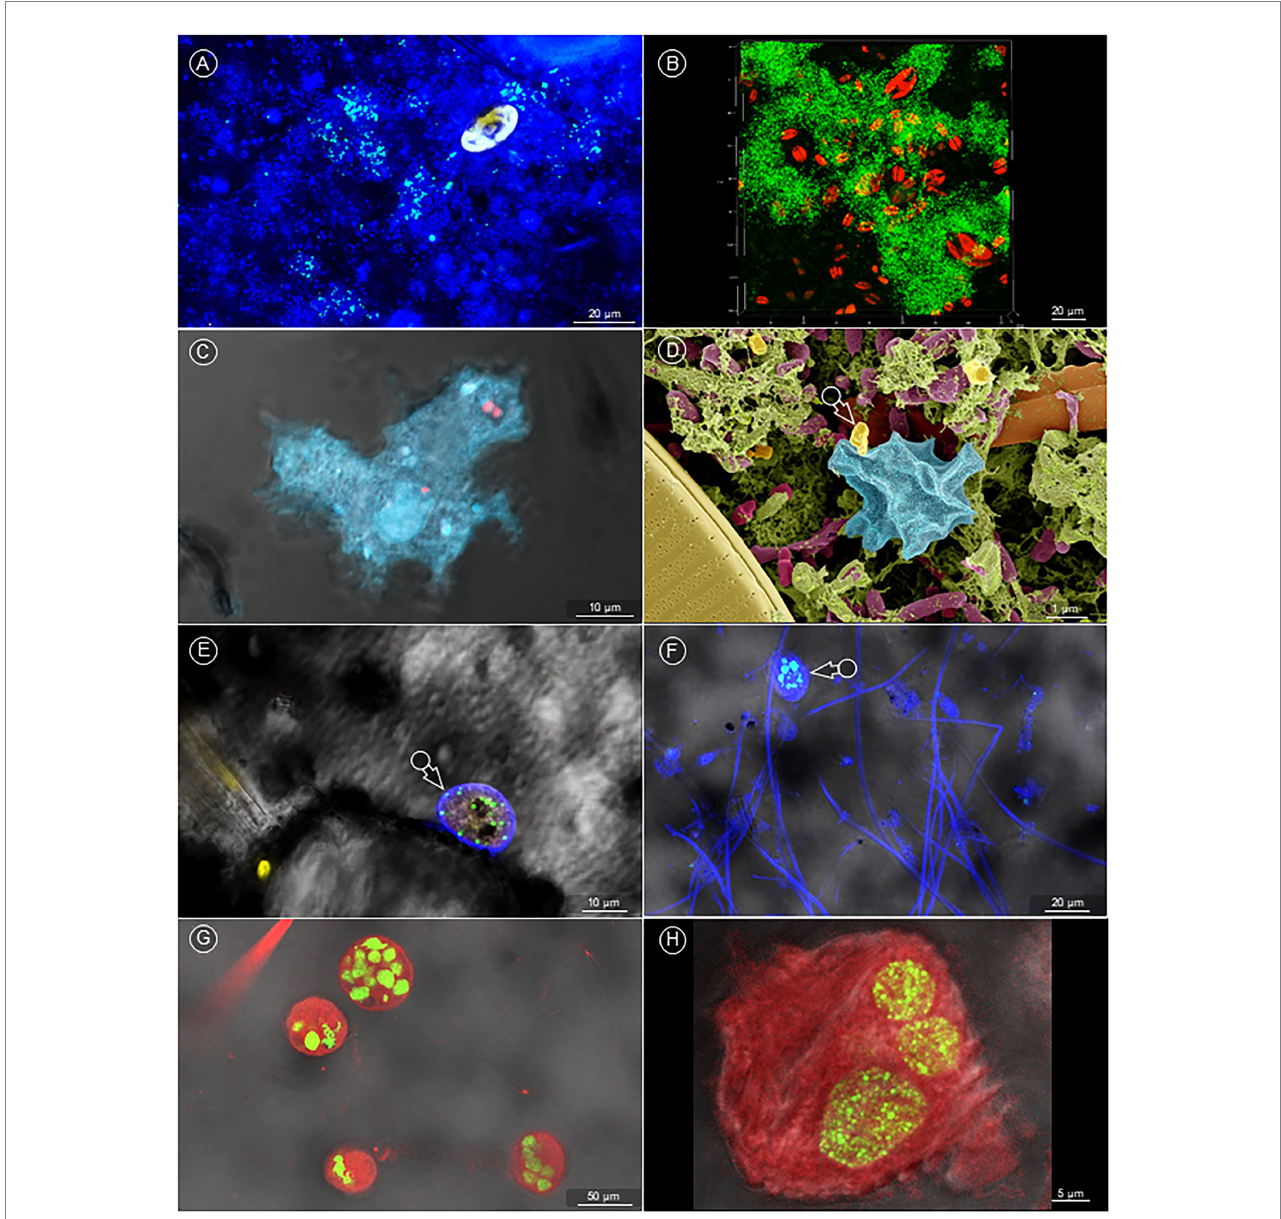
FIGURE 5 Visualization of Fth’ survival in natural ex vivo biofilm. (A) (CLSM image) GFP expressing Fth formed microcolonies (blue-greenish signal) within the natural biofilm (DAPI, dark blue) – diatom: yellowish autofluorescence). (B) (CLSM image) Fth formed a comprehensive, 3D biofilm (green) within the natural biofilm – diatoms: red autofluorescence. (C) (CLSM image) In the natural biofilm, Fth bacteria (red) were found ingested by amoebae (bright blue). (D) (SEM image) A bacterium, with the characteristic shape of Fth (arrow, compare with Figure 2B), is about to be ingested by an amoeba (bright blue). This scene enfolds between matrix (green) embedded bacteria (dark red) and various diatoms (ocker and orange). (E,F) (CLSM image) GFP expressing Fth bacteria within different types of ciliates (arrows). (G,H) Many Vorticella (red autofluorescence) in the natural biofilm showed accumulated Fth , which formed dense clusters